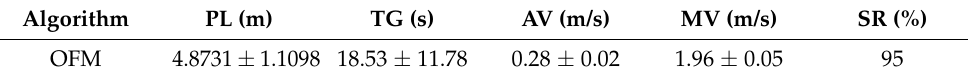
Table 3. The experiment results of the proposed collision-avoidance algorithm. A set of 100 experi- ments were conducted for the algorithm. OFM means the Only Forward Maneuver of the proposed algorithm. PL, TG, AV, MV, SR depict path length, time to goal, average velocity, maximum velocity, and success rate, respectively. These results obtained for the experiments of the scenario shown in Figure